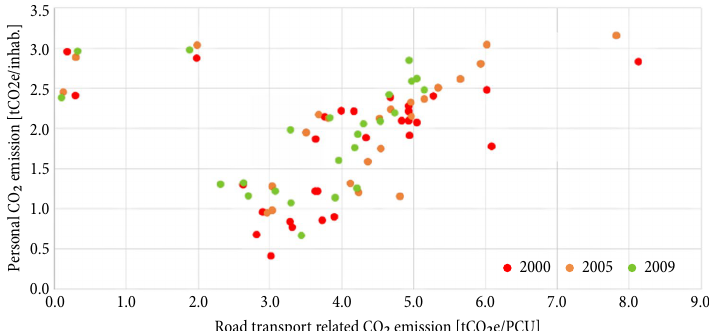
Fig. 6. Statistical development personal and transport-related emission rates (please note that only 2000, 2005 and 2009 were visualized in order to keep the resolution of figure)